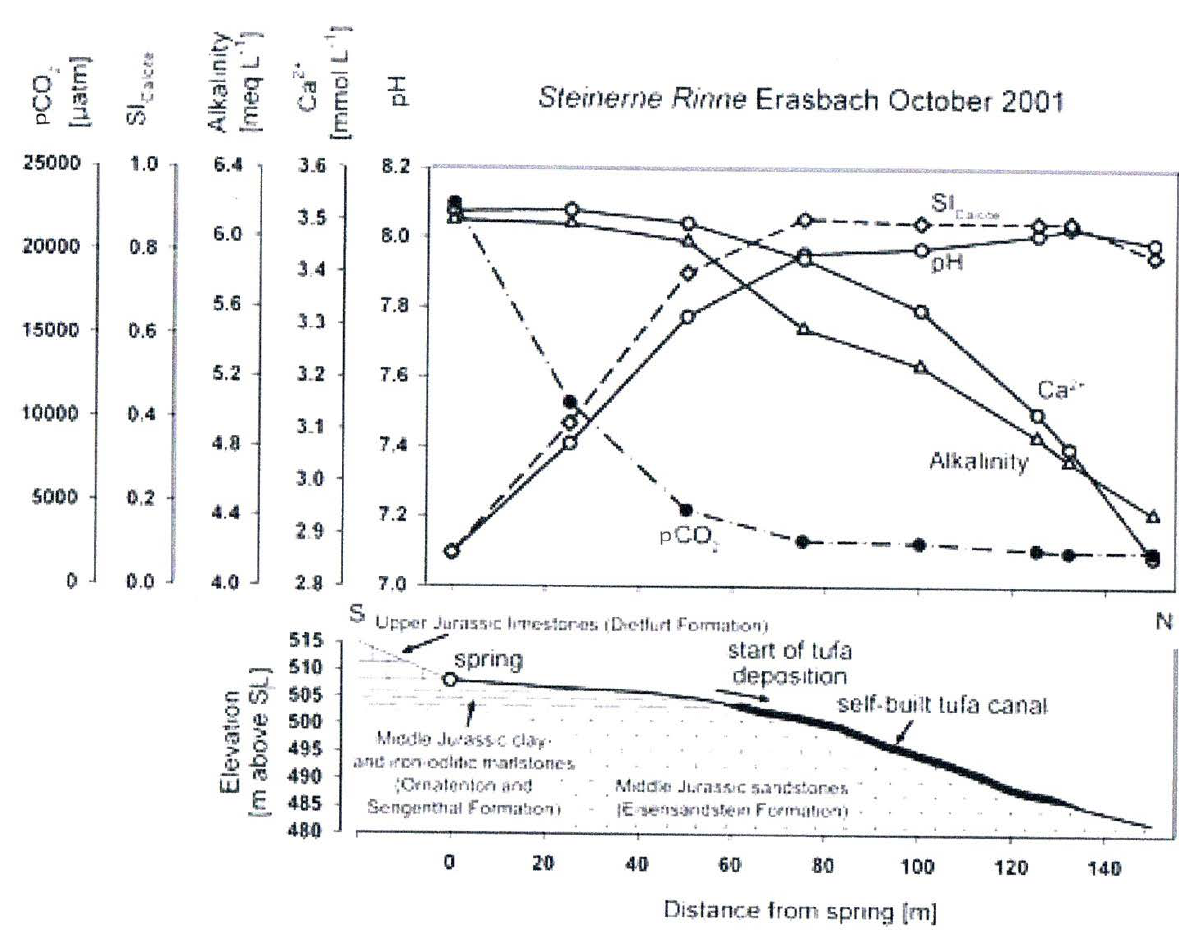
Figure 4. An example of the downstream changes in: CO 2 pressure (pCO 2 ), calcite saturation (Si calcite ), alkalinity, calcium concentration and pH along a travertine deposition stream. The outgassing of CO 2 results in an increase of the pH from about 7 up to 8–8.5. As the outgassing takes some time the precipitation of tufa usually starts somewhat downstream of the spring (after Arp et al.